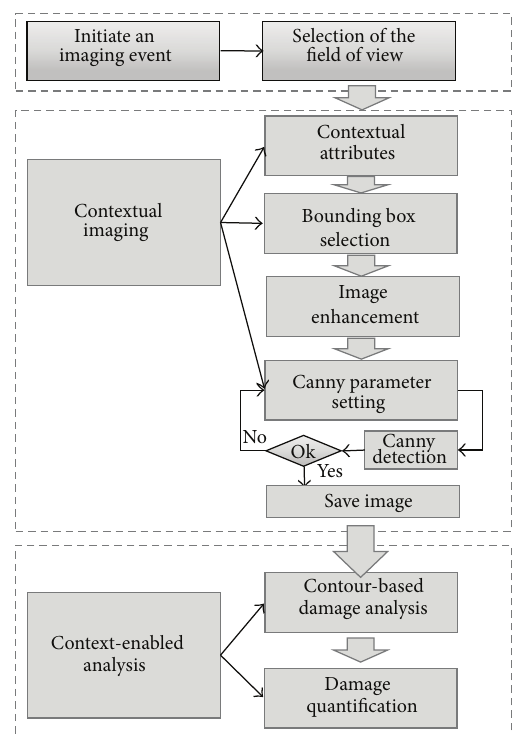
Figure 6: Mobile imaging and computing protocol for a typical crack scene